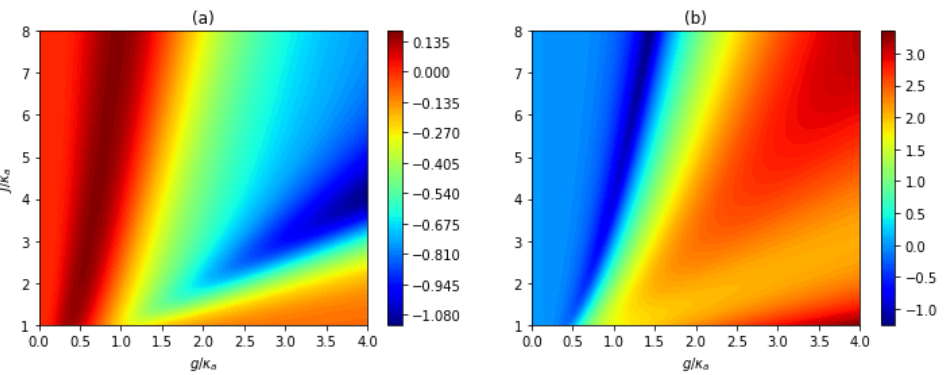
Figure 10. Plots of equal-time second-order correlation function g ( 2 ) ( 0 ) of ( a ) Cavity A and ( b ) Cavity B as a function of scaled atom-cavity coupling strength g / κ a and cavity interaction strength J / κ a for κ b = κ a , γ = 0.6 κ a , ε a = ε b = 0.1 κ a , and ∆ a = ∆ b = ∆ 1 =